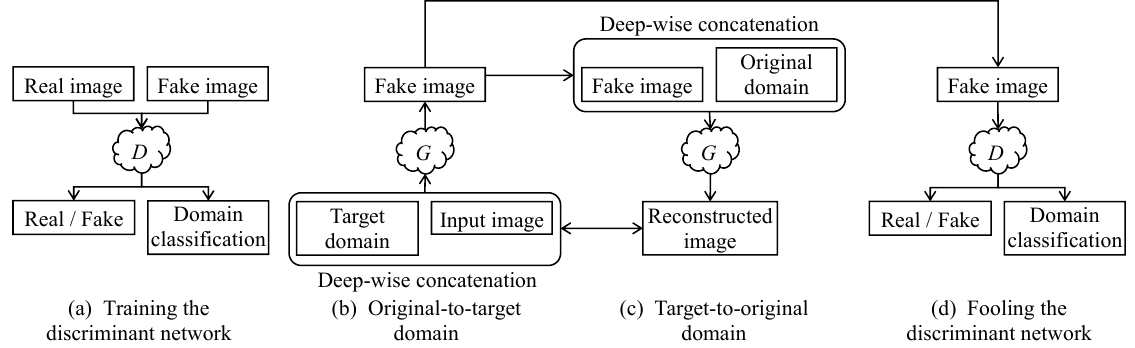
Figure 3. The framework of StarGAN. ( a ) D is composed of two modules and receives the real images and fake images. One is to distinguish real images from fake ones, and the other is to classify them into different domains. ( b ) G receives the target domain and input data and generates fake images. ( c ) G reconstructs the raw images using the fake image and original domain information. ( d ) D distinguishes the source of the image and its domain. A well-trained G can make D fail to complete this task.